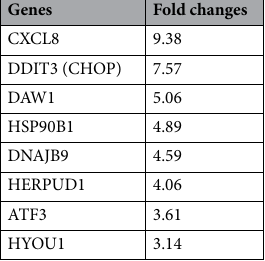
Table 2. Upregulation of UPR genes with AG-08